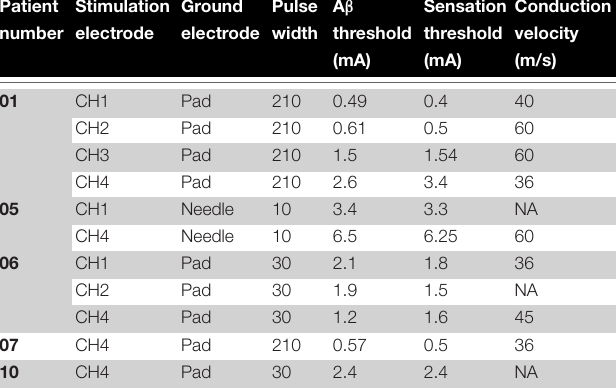
TABLE 3 | Relation between medium-velocity neural response threshold and sensation threshold for all experiments in which a clear A β neural response was observable.